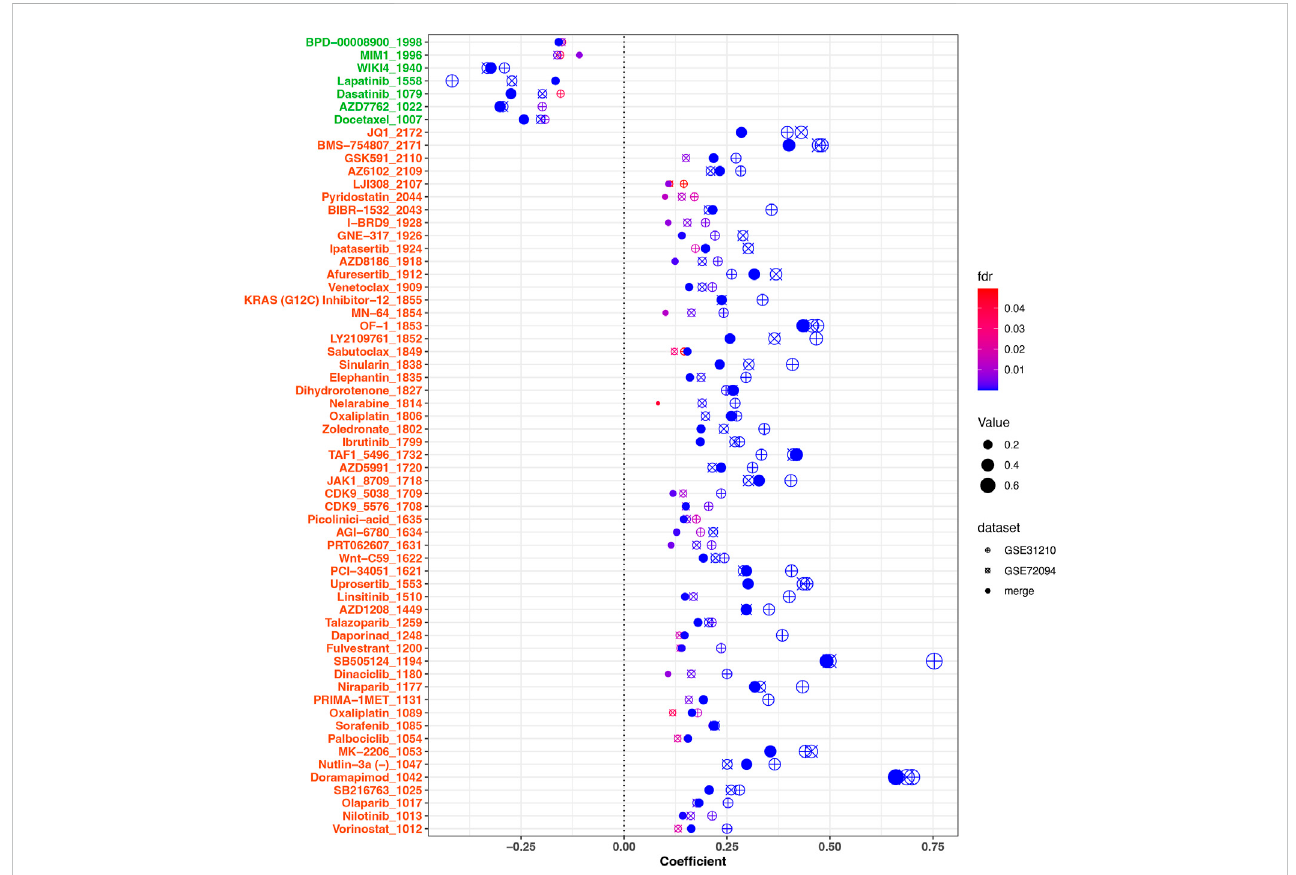
FIGURE 9 Correlationanalysisbetweendrugsensitivitiesofagentsandriskscores.61signi fi cantagentswererepresentedinthe fi gure.Thehorizontalordinatewas the correlation coef fi cient, while the ordinate represents the name of the drugs. Different shapes of dots represent different cohorts. The larger the dot, the greater the absolute value of the correlation coef fi cient. The color corresponded to the FDR value. On the ordinate, green marks negatively correlated drugs, while red marks positively correlated drugs. FDR < .05 was considered signi fi